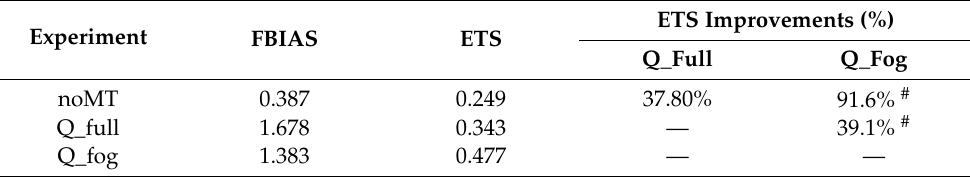
Table 2. Aggregated statistical scores averaged over the 1–6-h forecasts initialized every hour during the DA period from three cases for designed experiments. The marker # indicates the statistical significance at the confidence level of 95%. Experiment